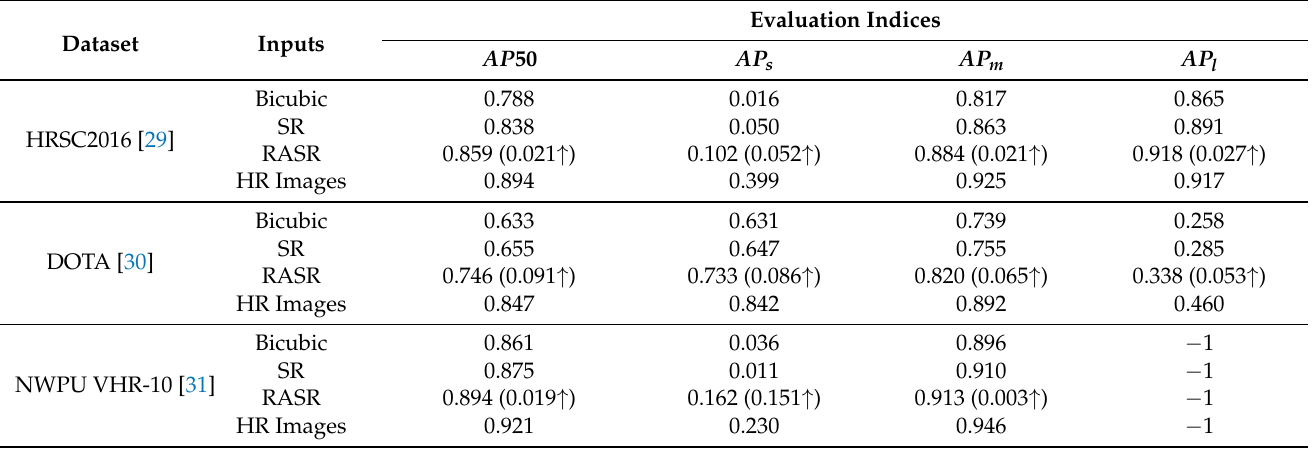
Table 3. Quantitative evaluation results of detection performance achieved by different variants of our proposed RASR. We use Faster-RCNN (with ResNet50 as backbone) as the evaluation detector, and use AP 50, AP s , AP m and AP l as the evaluation indices. Note that, since there is no large ship on NWPU VHR-10 dataset, the AP l on this dataset is −